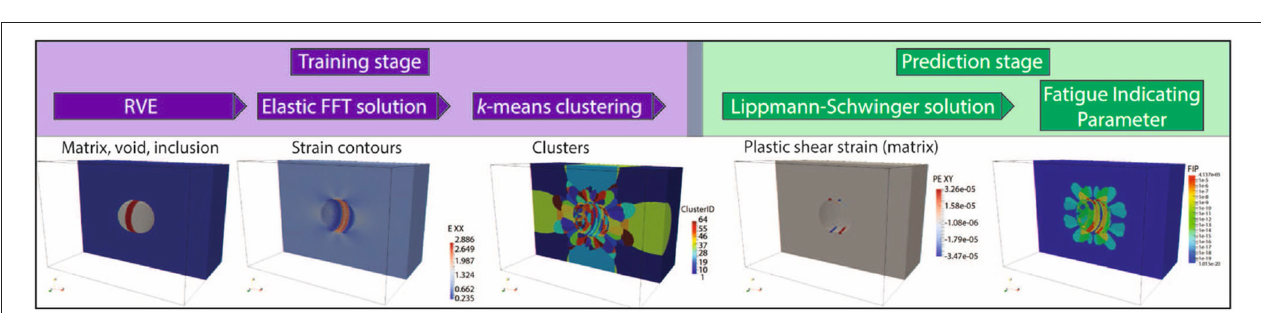
FIGURE 12 | Constant life diagrams (CLD) obtained via experiments and predicted via an artificial neural network (ANN) for coupons loaded in on-axis direction for 10 4 -10 7 load cycles for two glass-fiber reinforced polymers (GFRP) with laminate structure (A) [0/( ± 45) 2 /0] T and (B) [90/0/( ± 45)/0] S . Reprinted from Vassilopoulos et al. (2007), Copyright (2007), with permission from Elsevier.